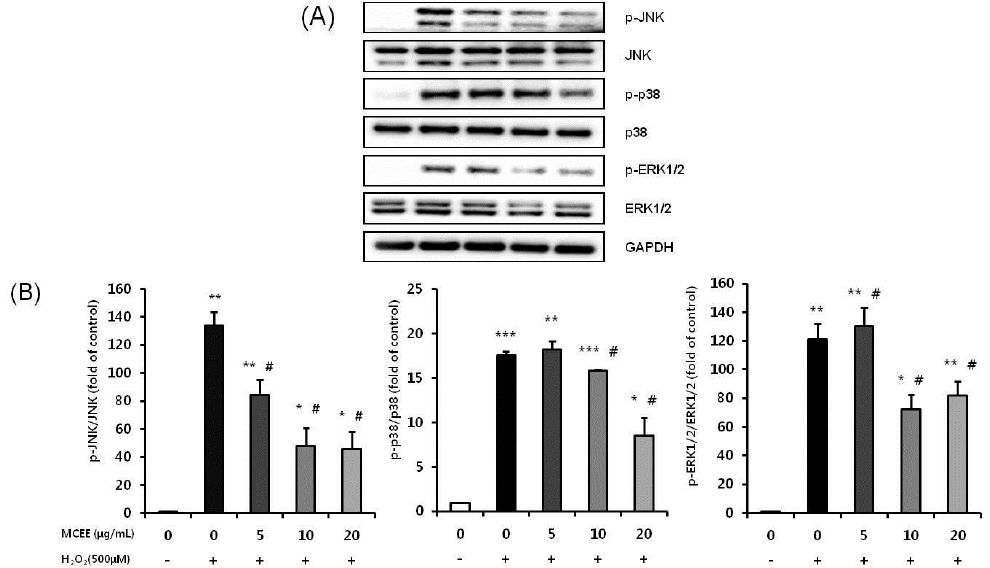
Figure 8. Neuroprotective effects of MCEE on the MAPKs pathway in H 2 O 2 -induced SK-N-MC cells. Cells were pretreated with the MCEE for 24 h and then treated with H 2 O 2 for 4 h. JNK, p-JNK, p38, p-p38, ERK 1/2, and p-ERK 1/2 protein expression levels were confirmed by Western blot analysis. ( A ) The proteins expression by Western blot analysis. ( B ) Quantitative analysis of the bar graphs showed the densities of the protein bands. Data are shown as means ± S.D. ( n = 3). * p < 0.05; ** p < 0.01; *** p < 0.001 compared with the untreated control cells, # p < 0.05 compared with only H 2 O 2 -treated cells.